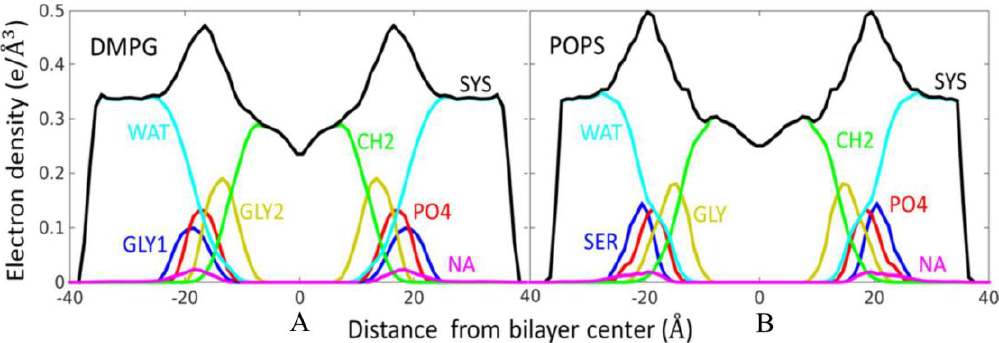
Figure 6. The total and decomposed electron density profiles of the lipid molecule. ( A ) The electron density profiles of the DMPG; ( B ) The electron density profiles of the POPS.